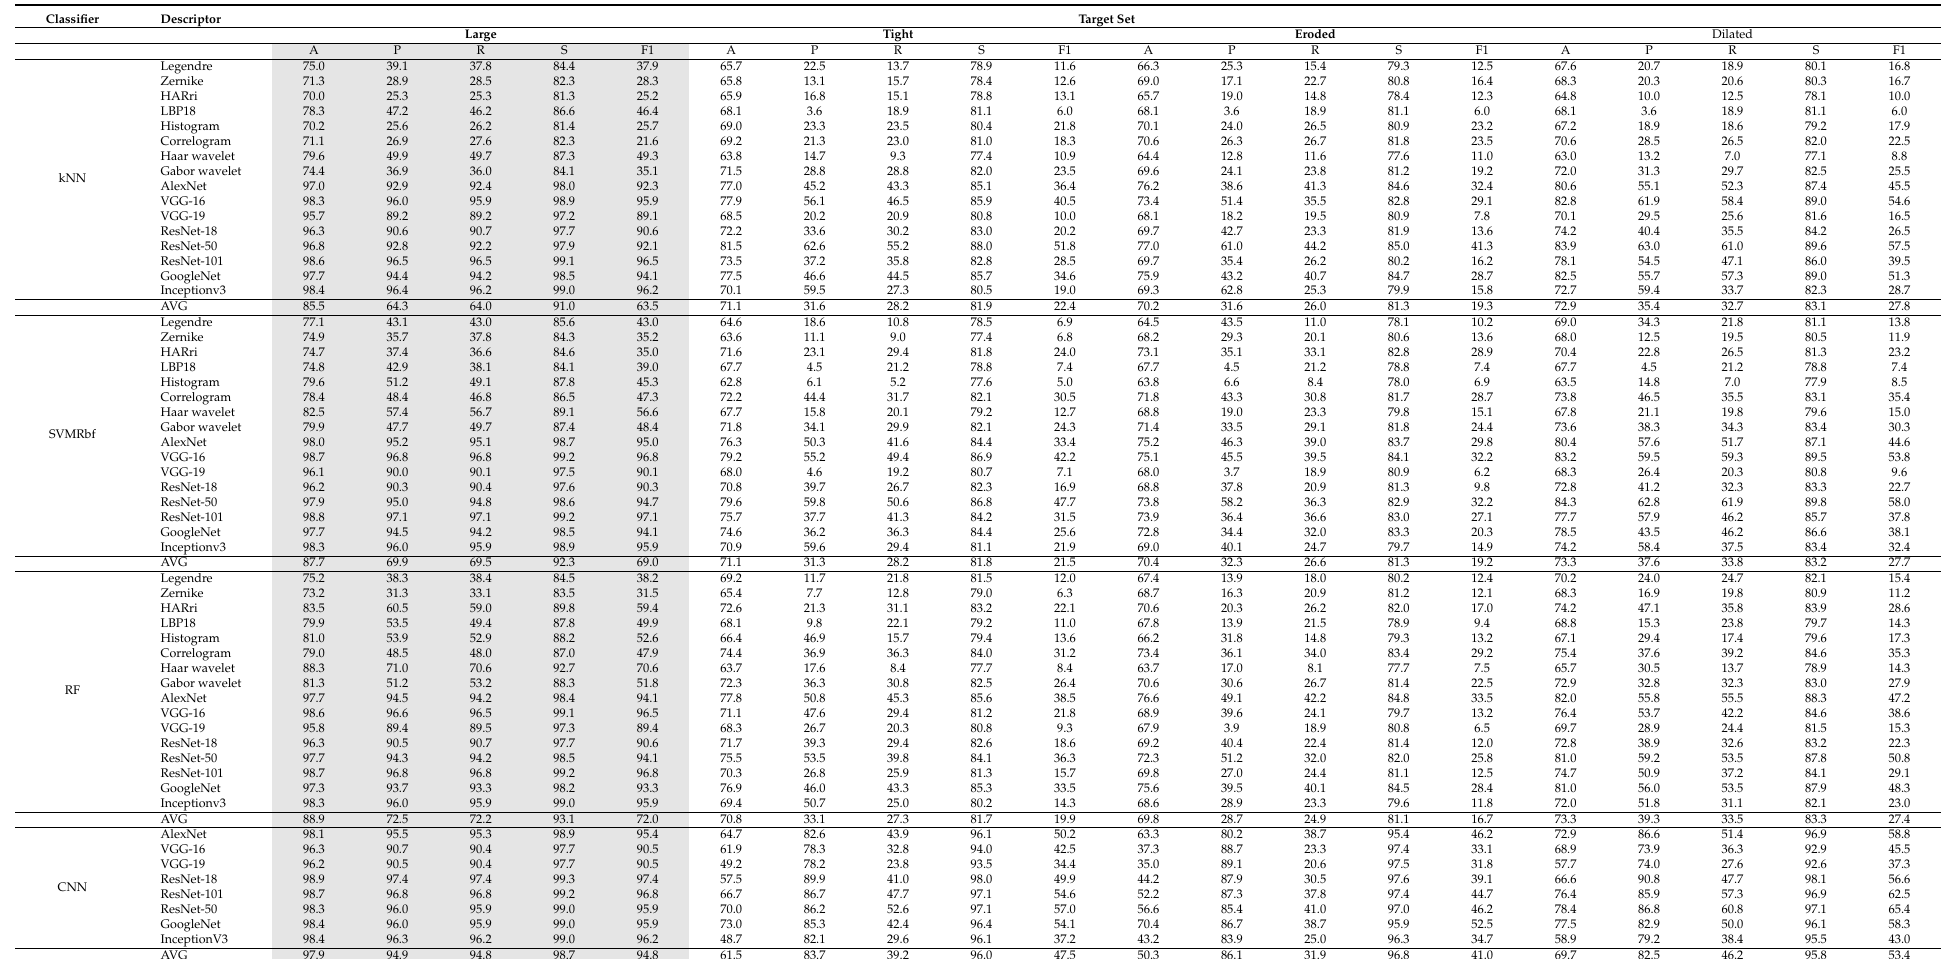
Table 3. R-WBC performance obtained with source models created exploiting the large data set version and tested using in turn (from the left) the large, tight, eroded and dilated versions. Same-version performance are highlighted in